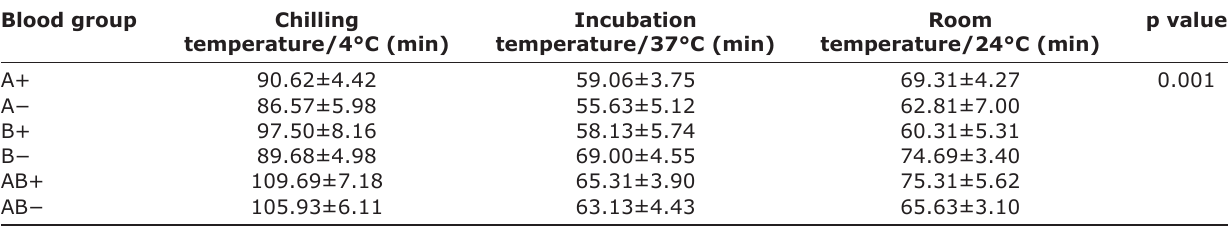
Table-6: Time required for HA of human RBC with VVNDV (field isolate) within different temperatures (mean±SD). Blood group